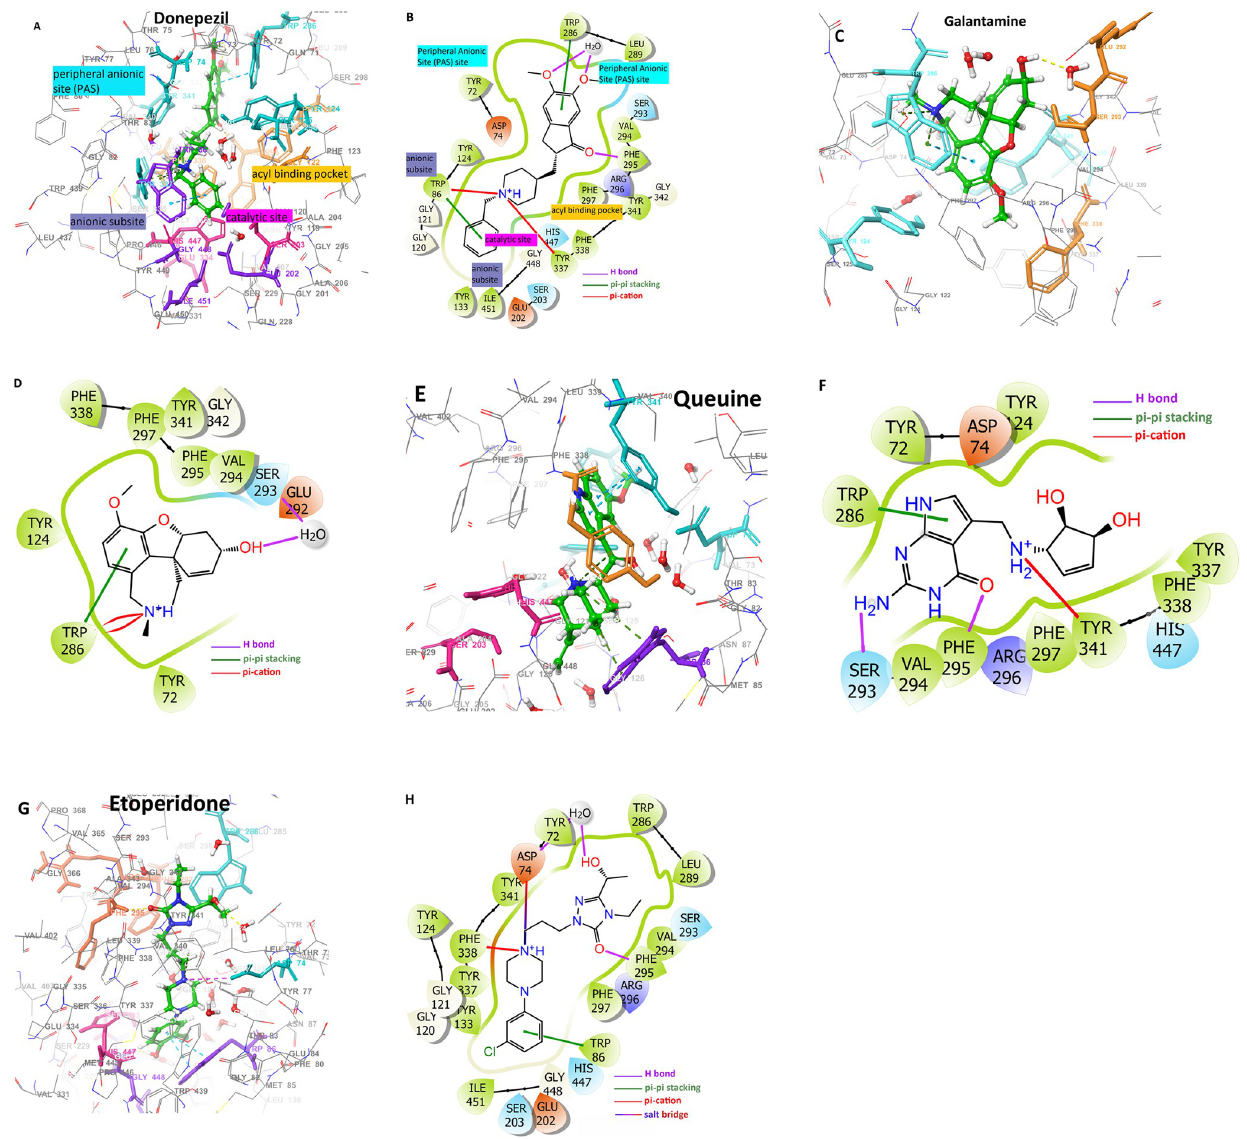
Fig 2. Docked conformations and important binding site interactions of suggested natural compounds as compared to control molecules. Panels A-B for Donepezil (3D-2D), C-D for Galantamine (3D-2D), E-F for Queuine (3D-2D) and G-H for Etoperidone (3D-2D) respectively. Coloring indicates: CAS (magenta), PAS site (cyan), anionic site (purple), and acyl binding site (orange). https://doi.org/10.1371/journal.pone.0284994.g002 We performed MD simulations for each molecule double runs for 100 ns. Fig 3 demon- strates the root mean square deviations (RMSD) (A), root mean square fluctuations (RMSF) (B), protein-ligand interactions (C-D), solvent accessible surface area (SASA), radius of gyra- tion (rGyr) and intramolecular hydrogen bonds (intraHB) within the ligand (E), through MD simulations of Queuine-AChE complex system. RMSD results (Fig 3a) compare the Apo AChE with Donepezil, Galantamine and Queuine bound forms. All trends converges lower than 2.5 Å confirming the establishment of equilibration and a stable simulation. Donepezil RMSD values are lower than 1.5 Å , implying comparably a more stable complex formation; while Galantamine and Queuine exhibit similar profiles, i.e. similar protein-ligand stability,